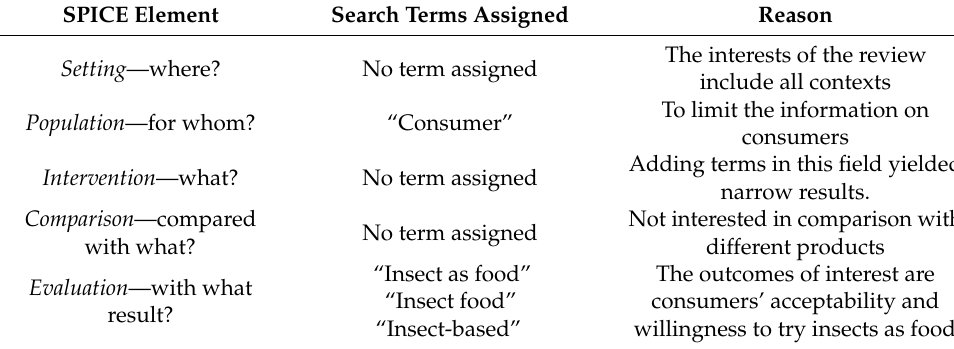
Table 1. SPICE framework used for the database search